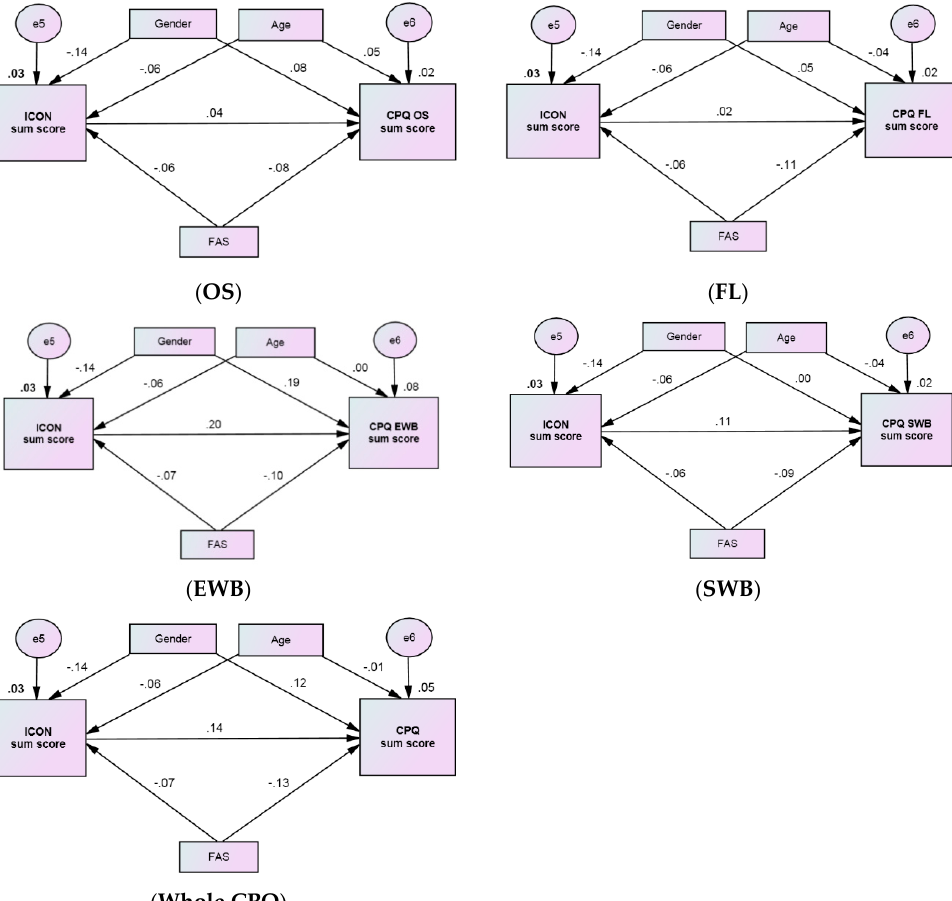
Figure 1. Path diagrams representing the strength of association among FAS, ICON, and the sum scores of the CPQ by CPQ domains (oral symptoms (OS), functional limitations (FL), emotional well-being (EWB), and social well-being (SWB)) and the CPQ as a whole, adjusted by gender and age.